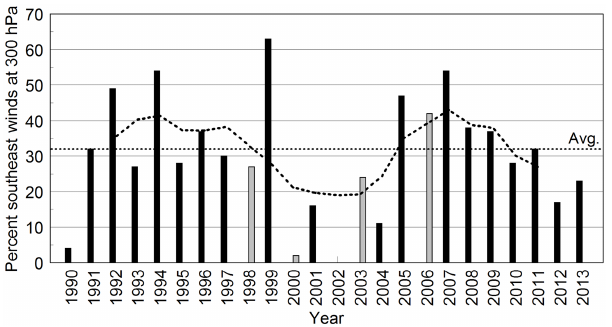
Figure 3. Percent of 300hPa wind directions between 67.5 ◦ and 202.5 ◦ (southeast) for each year 1990–2013 for mid-November through December. Experiment years are shaded gray and the longer-term variability shown using a 5-year smoothing. The year 2002 was eliminated because of the never-before-seen sudden stratospheric warming which occurred that year and may have af- fected the tropospheric circulation (Charlton et al., 2005). The av- erage over 20 years is shown by the dashed